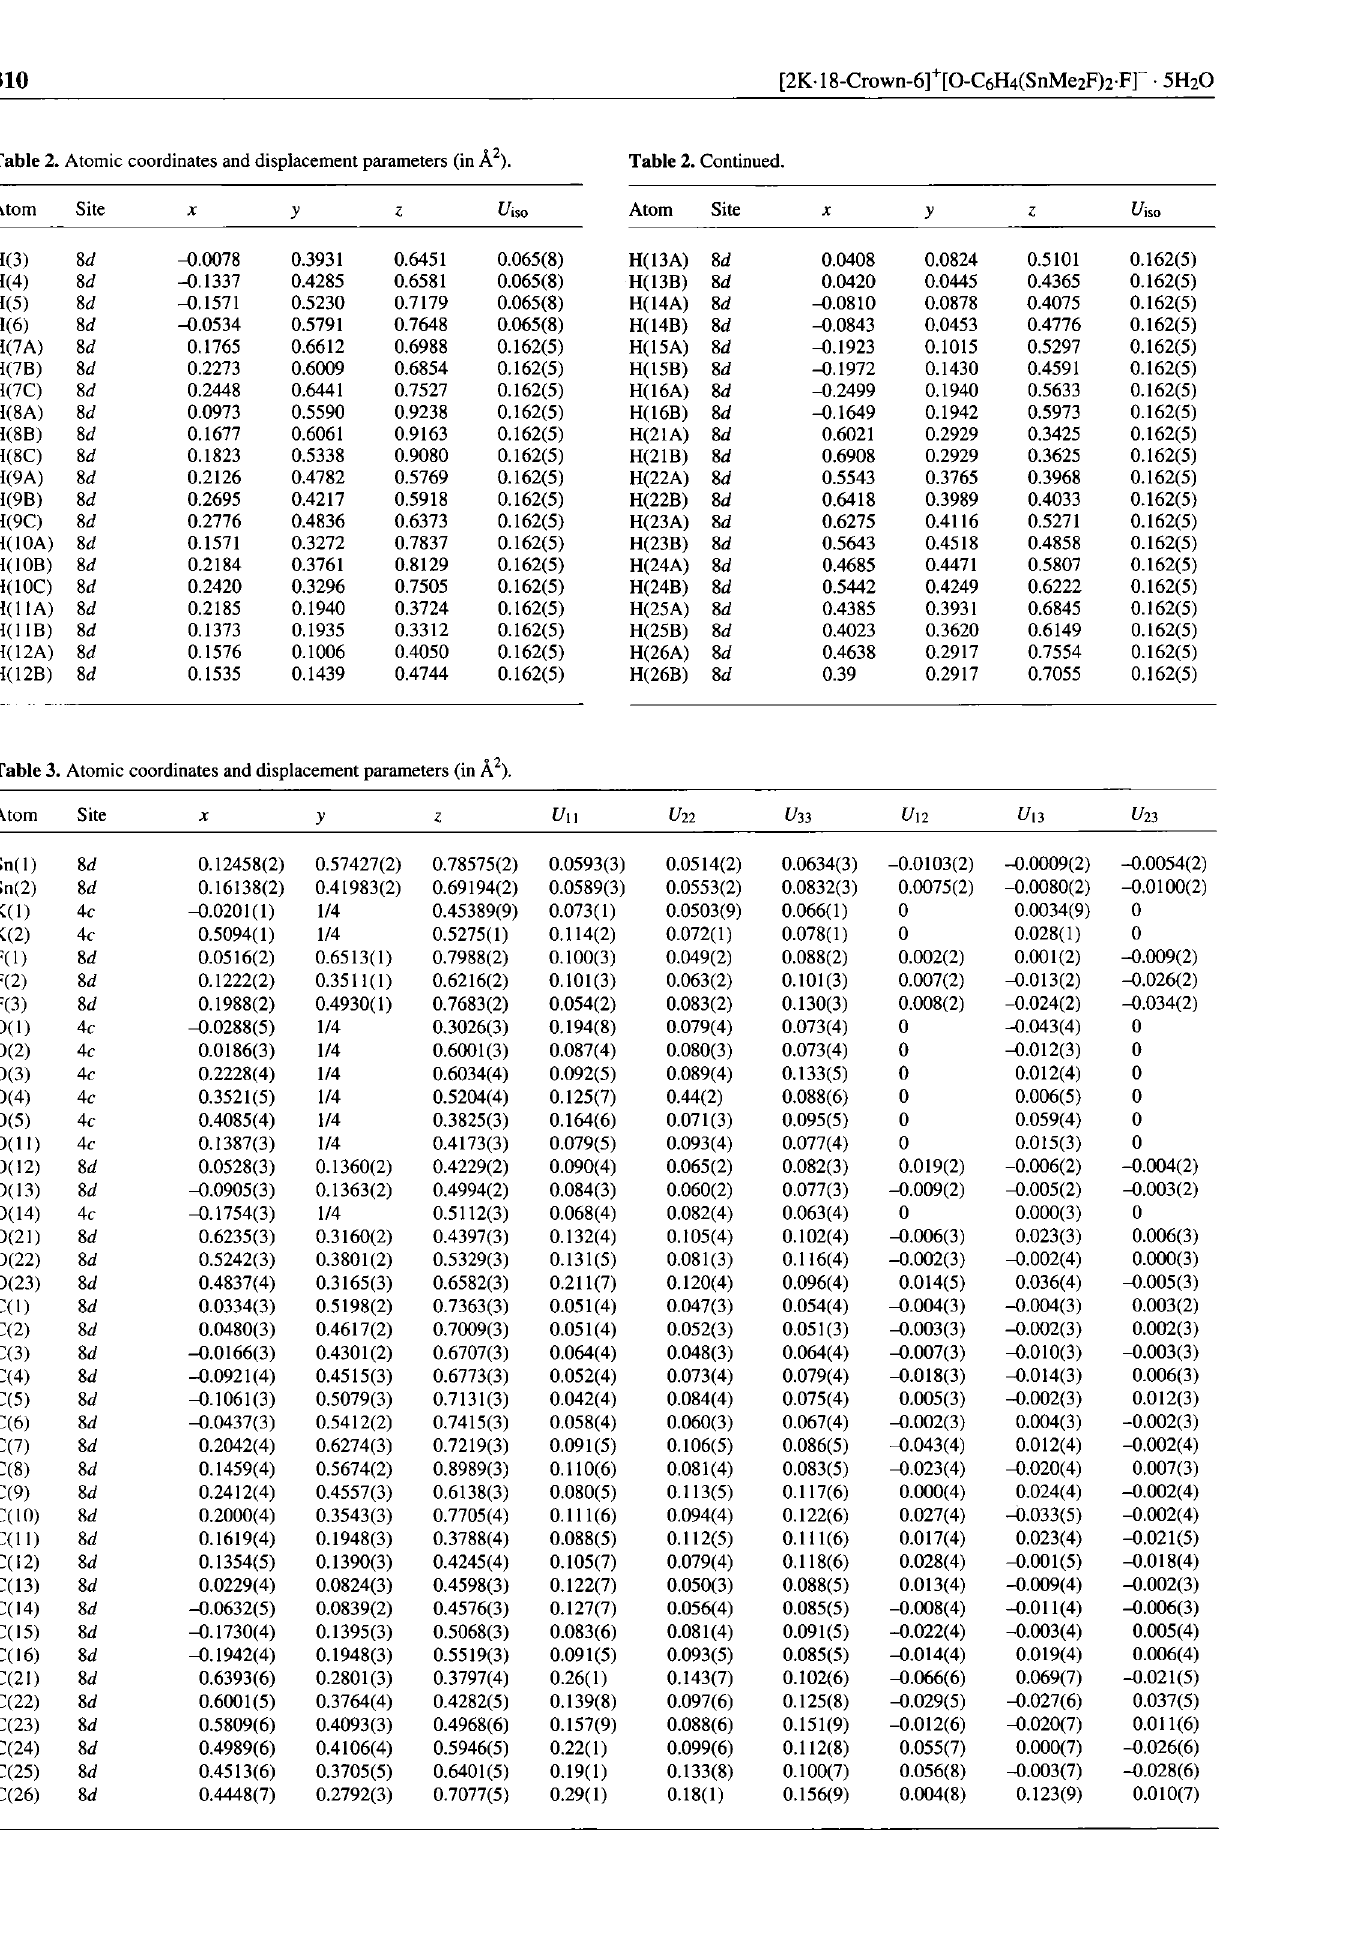
Table 2. Atomic coordinates and displacement parameters (in A 2 ).